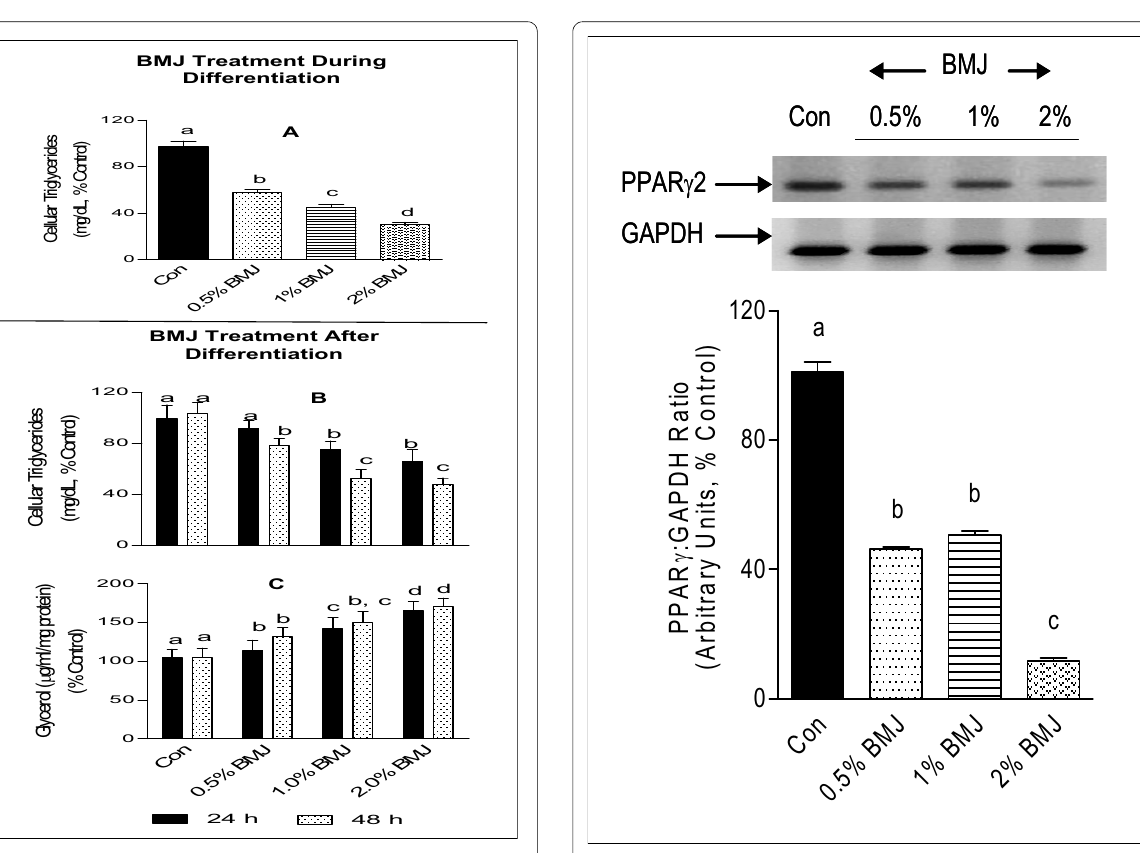
Figure 3 Effect of bitter melon juice on cellular triglyceride mass . Cellular triglyceride levels were reduced in (A) differentiating preadipo- cytes treated with varying concentrations of BMJ during differentiation and (B) adipocytes treated with varying concentrations of BMJ for 24 and 48 h. Figure 3C depicts the increased release of glycerol into the media, when adipocytes were treated with varying concentration of BMJ (0.5% to 2%, v/v) for 24 and 48 h. Values represent the mean ± SE (n = 6) of three independent experiments conducted in duplicate. a, b, c, d Mean values with common letters do not differ (p < 0.05).